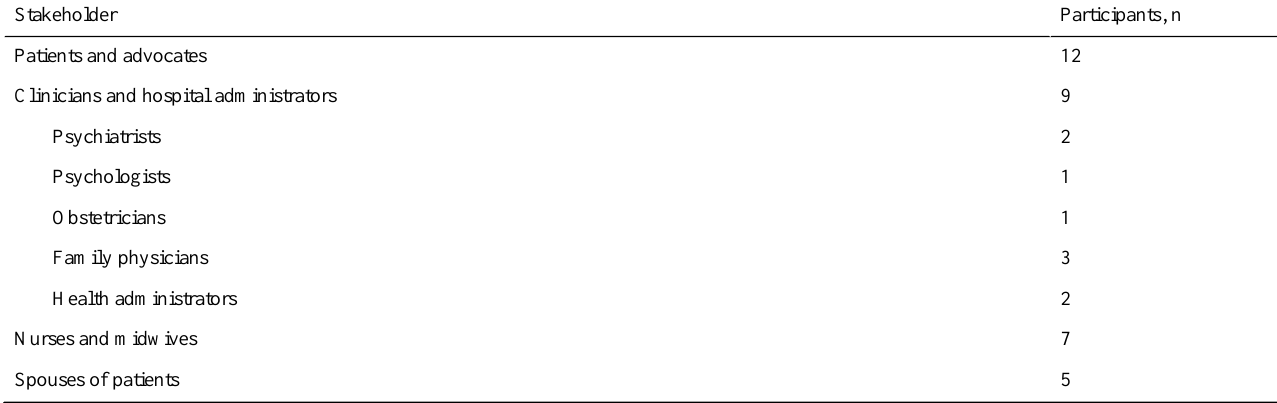
Table 1. Participants by stakeholder group